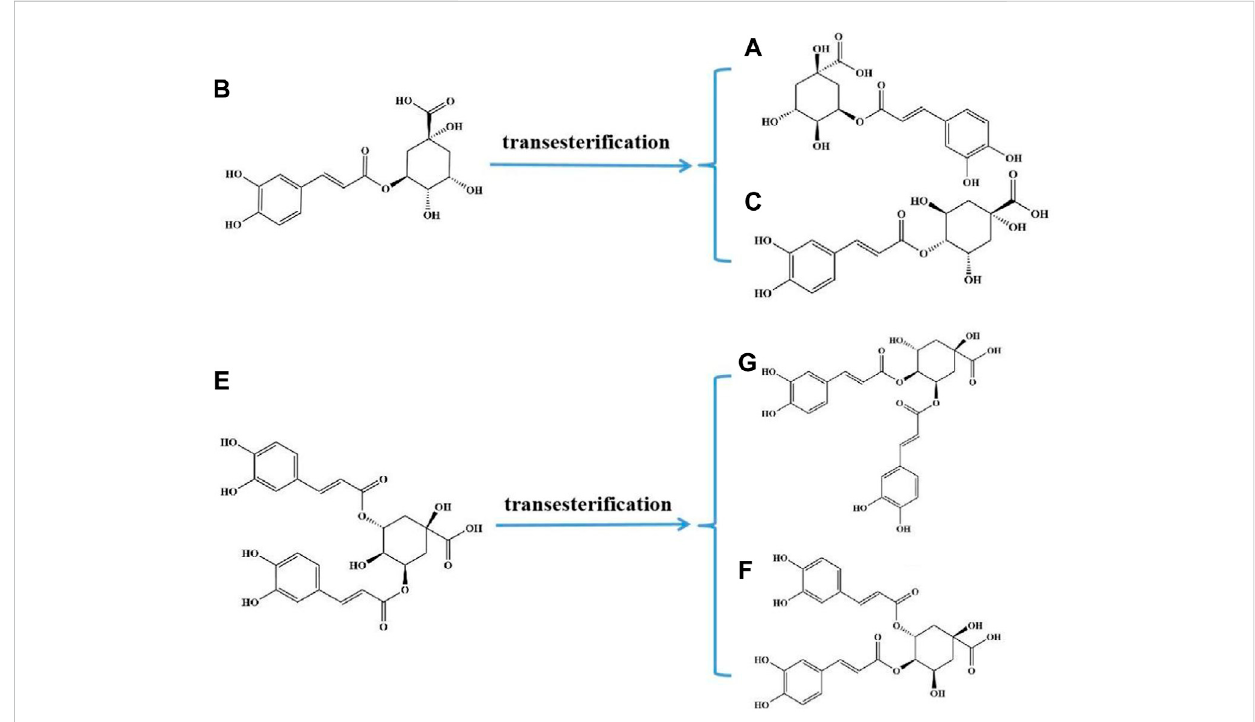
FIGURE 7 Possible chemical changes in the phenolic acids of PS during the stir-frying process. (A) : 5-CQA; (B) : 3-CQA; (C) : 4-CQA; (D) : CA; (E) : 3,5-DiCQA; (F) : 3,4-DiCQA; (G) :